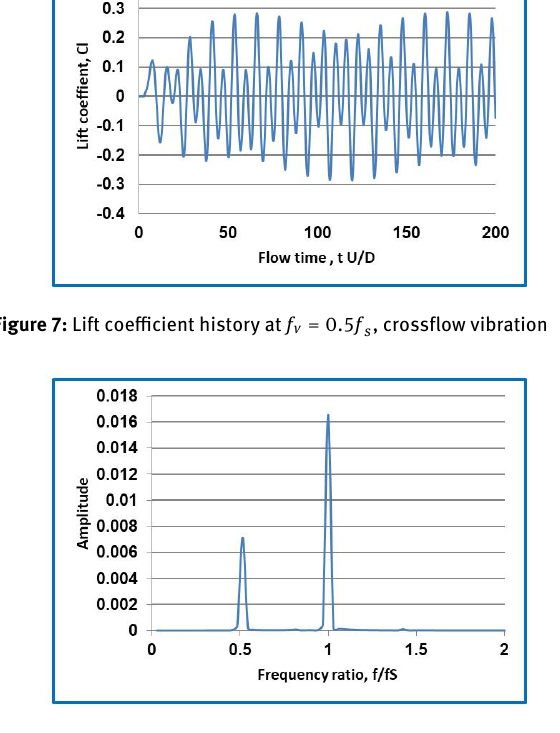
Figure 8: Power spectrum of lift coeflcient history at f v = 0.5 f s , crossflow vibration